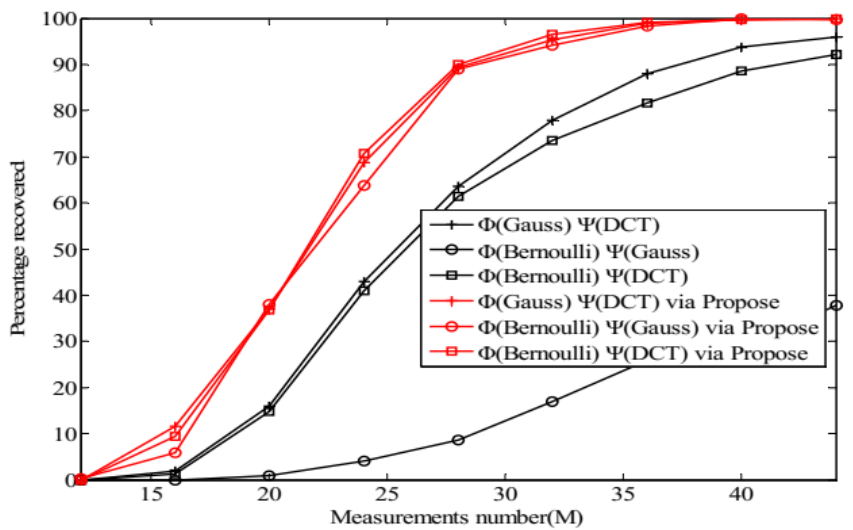
Figure 8. The change tendency of P suc with M while K = 8 in the noiseless case.